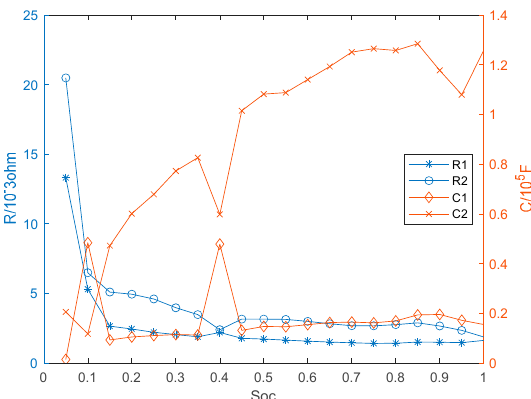
where U cell ( k ) is the voltage measurement value; U is the voltage measurement value; is the estimation derived where ( ) cell Equation (3); and ff is the objective function value. from Equation (3); and ff is the objective function value.